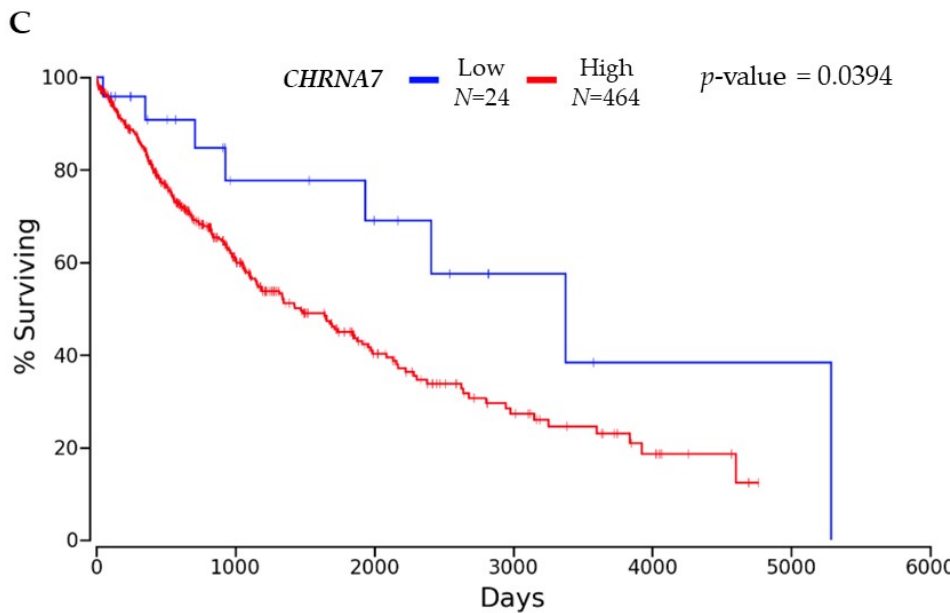
Figure 1. CHRNA7 expression and clinicopathological correlations in TCGA-LUSC cohort. ( A ) Expression levels of CHRN subunit genes in normal lung from GTEx portal. ( B ) Boxplots of CHRNA7 gene expression comparing normal lung tissues against different stages of lung cancer (upper panel), or non-smoking patients against patients with different smoking habits (lower panel) in the TCGA-LUSC dataset; median of each bar is shown. ( C ) Kaplan–Meier analysis of lung squamous cell carcinoma patients in the TCGA-LUSC cohort (Oncolnc).